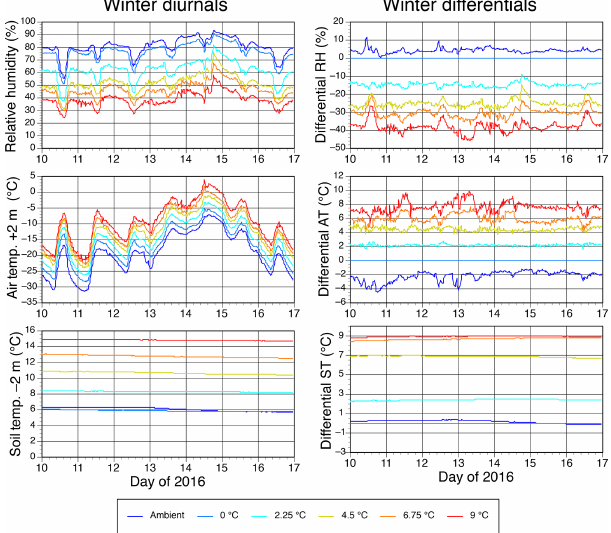
Figure 9. A cold-season, 7-day example of the diurnal variations in air temperature and relative humidity at + 2m, and soil temperatures at the reference depth of − 2m. Calculated differentials with respect to reference plot 6 are provided in the right-hand